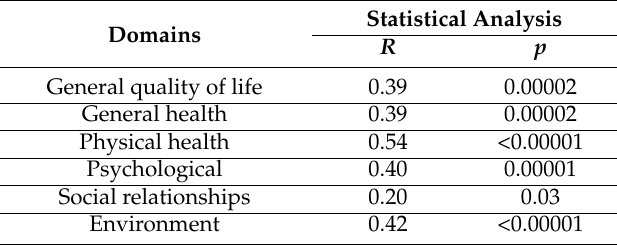
Table 7. Correlation between the acceptance of illness (AIS) and quality of life (QoL) scores.